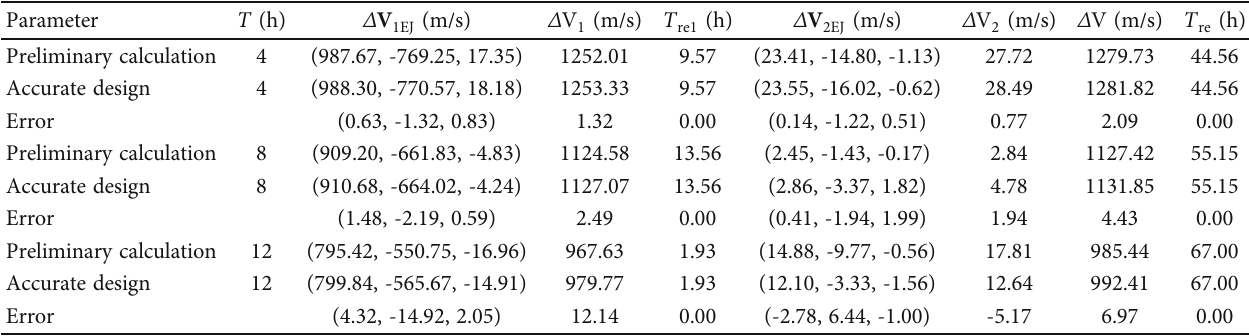
Table 4: The results of the two-impulse abort orbits (when the maximum abort return time is 1.5 times the minimum return time of a single-impulse abort orbit).